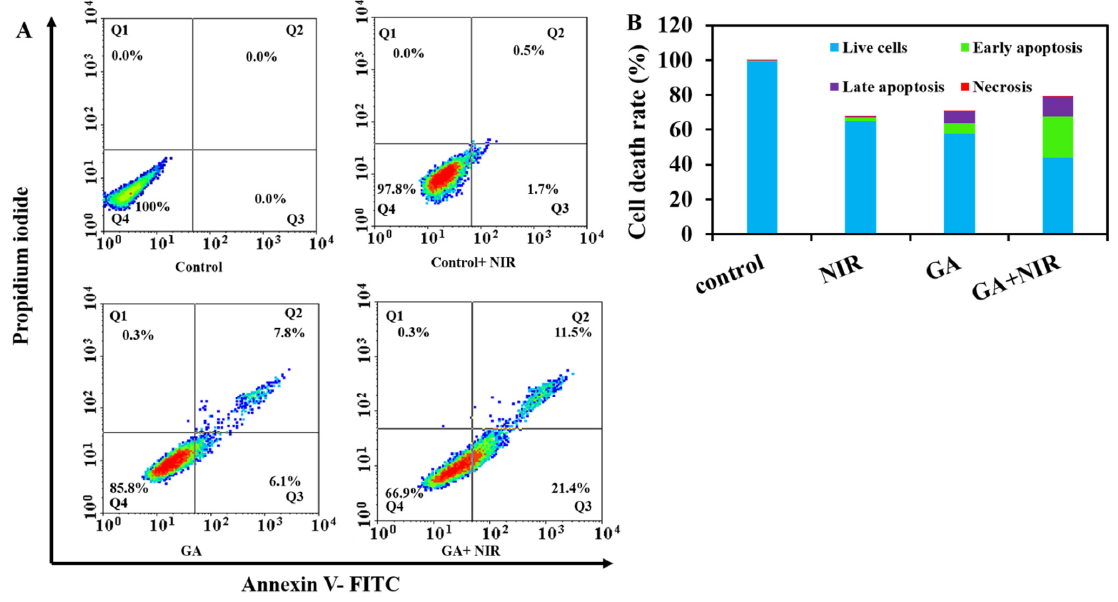
Figure 7. Apoptosis and necrosis of C6 cells analysis using flow cytometry with annexin V- FITC/propidium iodide (PI) dual staining. ( A ) Two-dimensional scatter plots of annexin V-FITC vs. PI from flow cytometry. Cells staining negative for annexin V-FITC and PI in the lower left quadrant are live cells. Cells staining positive for annexin V-FITC and negative for PI in the lower right quadrant represent early apoptosis. Cells staining positive for annexin V-FITC and PI in the upper right quadrant are late apoptotic. ( B ) Summary of the annexin V-FITC apoptosis assay results showing the percentages of cell-death modes: necrosis, late apoptosis, early apoptosis, and live cells.